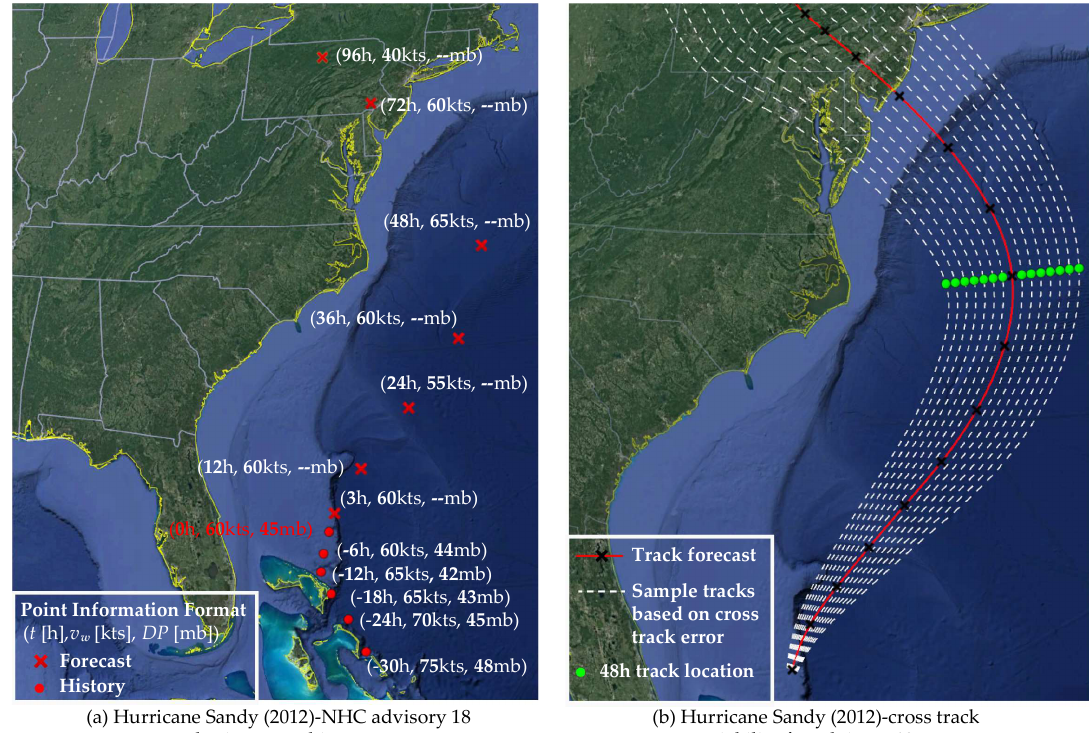
Figure 1. ( a ) NHC advisory 18 for super storm Sandy, combining past (indicated with t < 0) and forecast (indicated with t > 0) information for track and intensity (sustained wind speed v w and pressure difference DP ). ( b ) Storm tracks obtained considering the cross-track variability of the nominal track forecast shown in part ( a ). Green circles correspond to the storm track forecast at 48 h from the current position and represent the samples for the cross-track error for the current sampling process implemented in P-Surge.